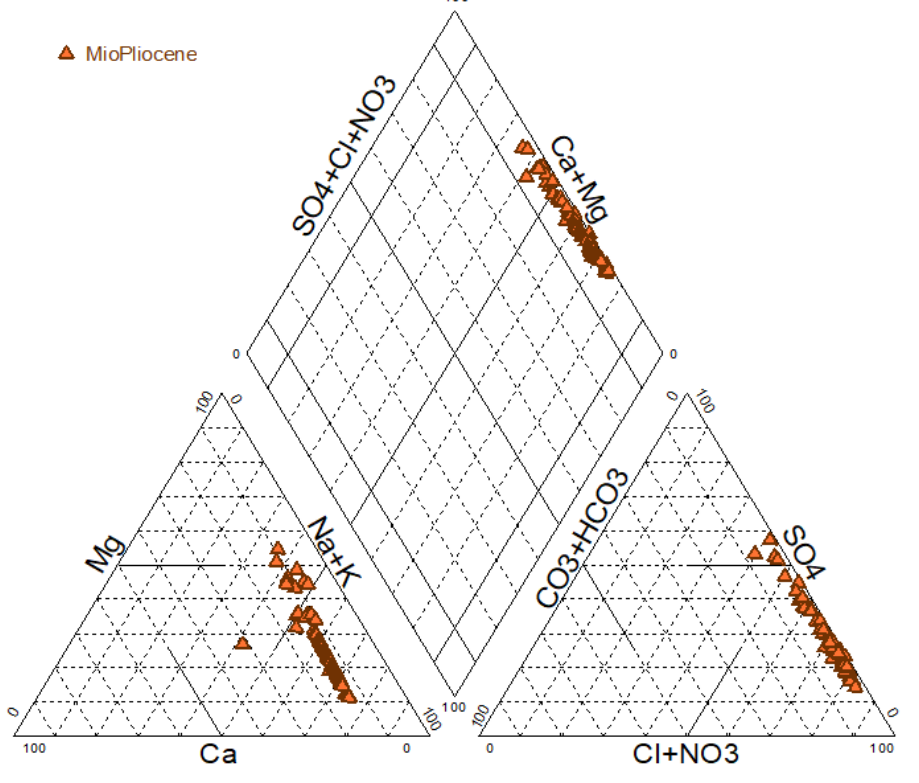
Figure 4. Groundwater samples plotted on the Piper diagram. Table 3. Classification of Ouargla basin